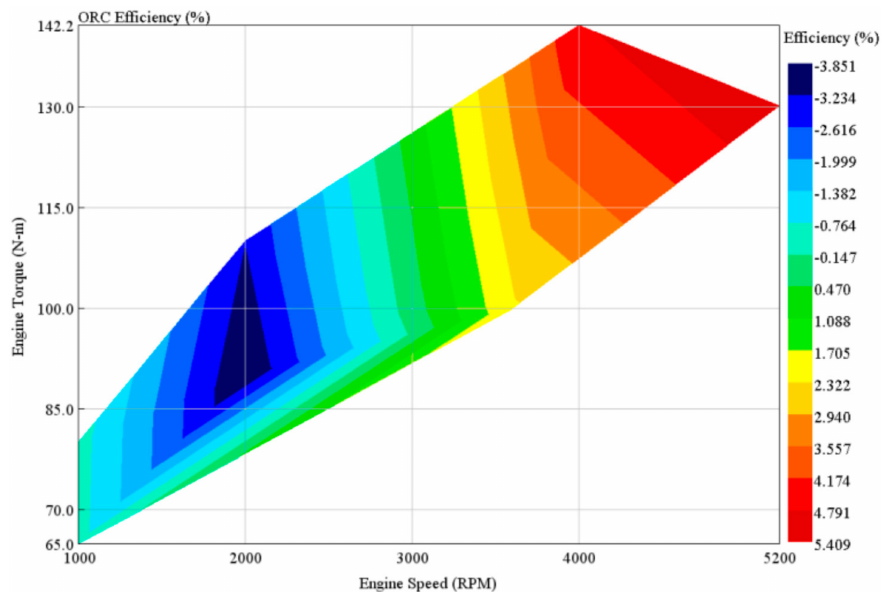
Figure 24. ORC E ffi ciency